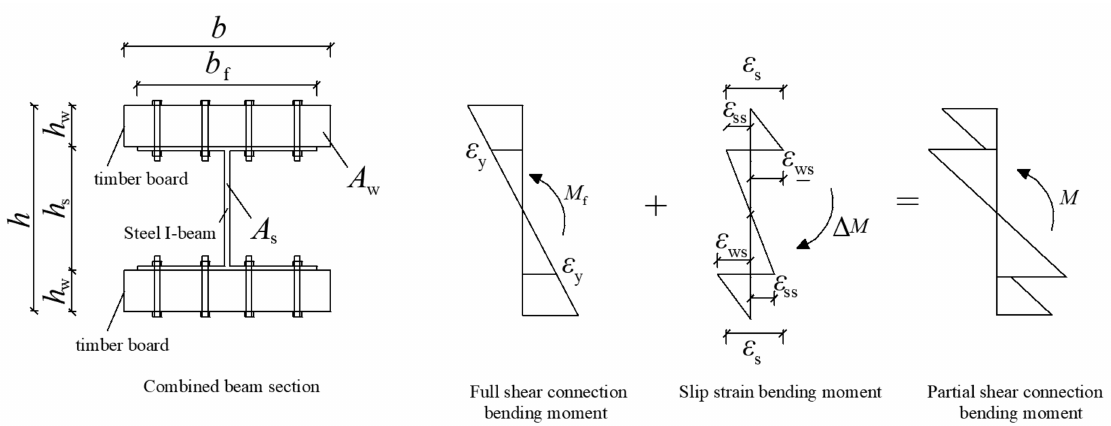
Figure 4. Model for calculating the ultimate elastic flexural load capacity of a partially composite